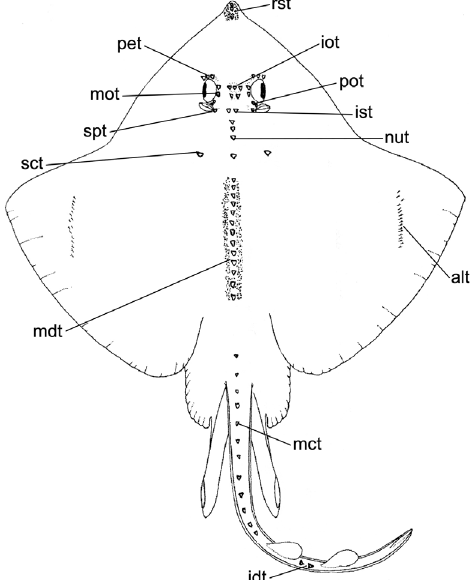
FIGURE 1 | Terminology of thorns. alt , alar; idt , interdorsal; iot , interorbital; ist , interespiracular; mct , mediocaudal; mdt , middorsal; mot , midorbital; nut , nuchal; pet , preorbital; pot , postorbital; rst , rostral; sct , scapular; spt ,